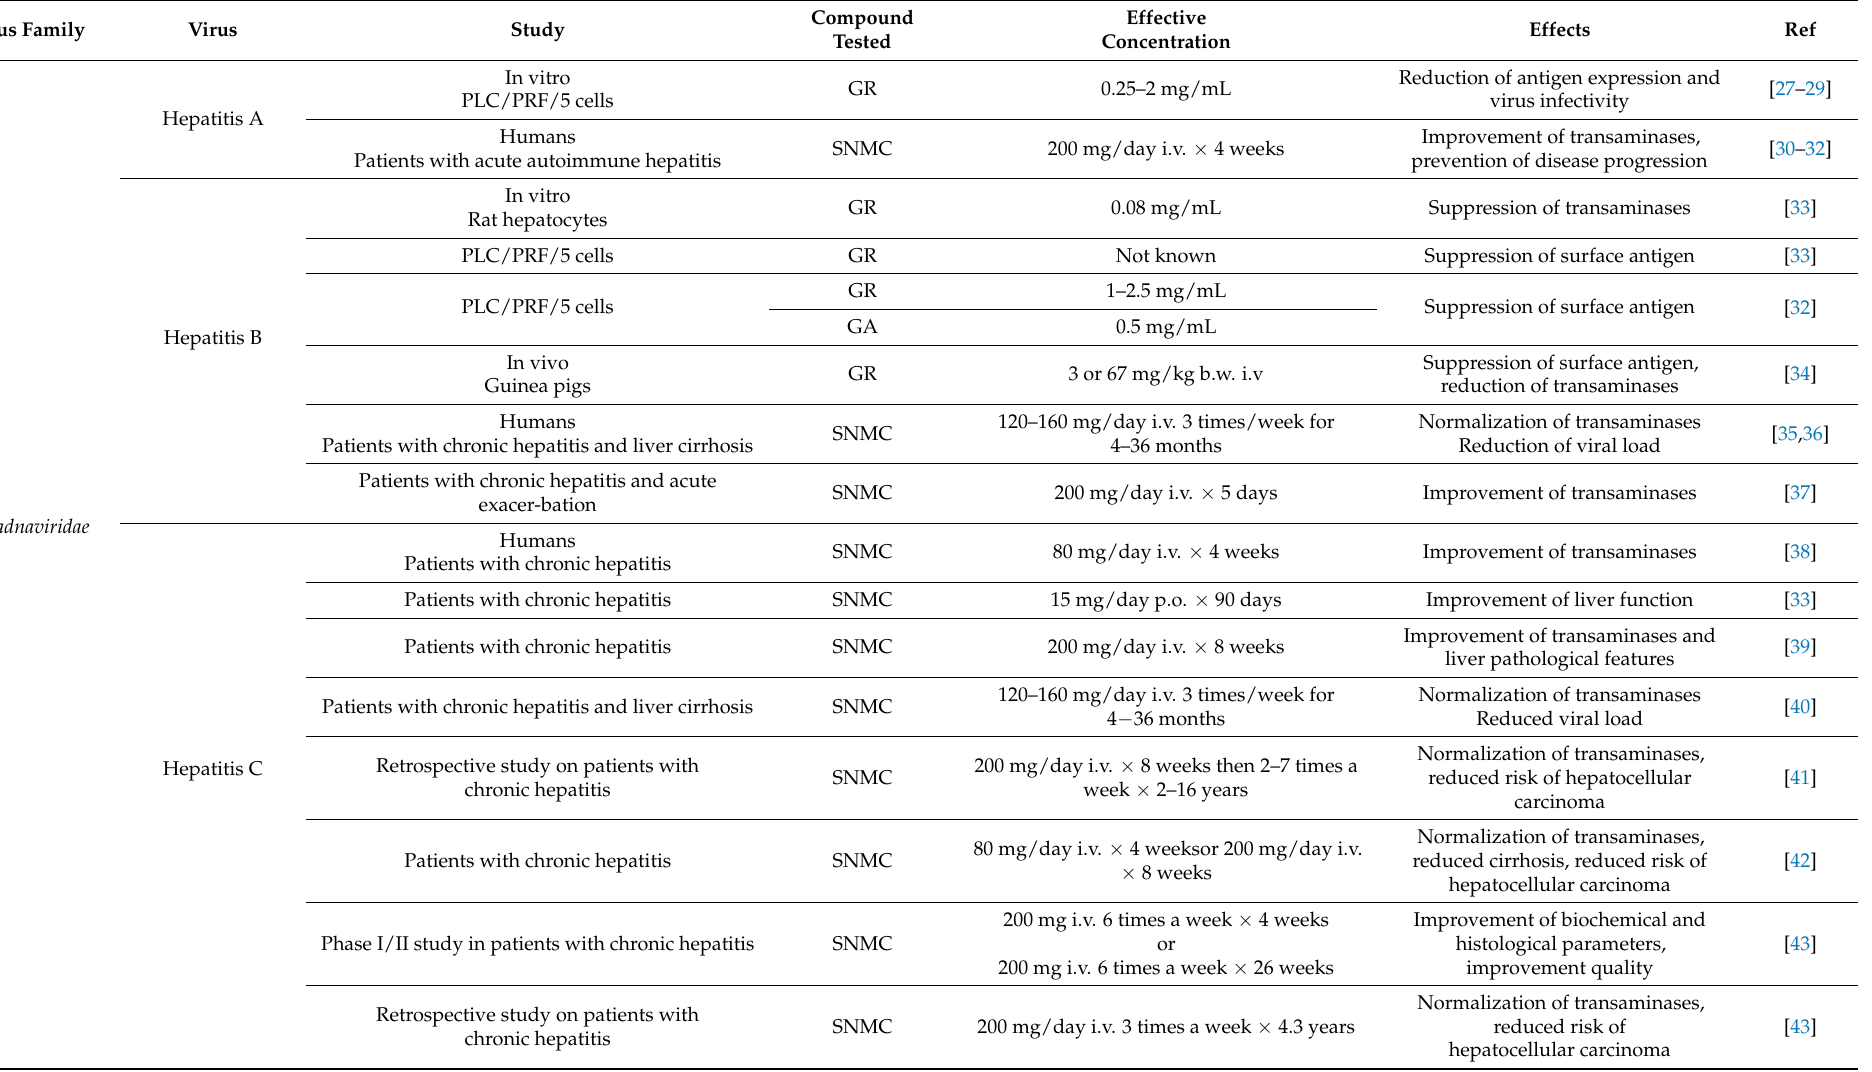
Table 2. Summary of the main studies on licorice extracts, GR and GA, against several unrelated DNA and RNA